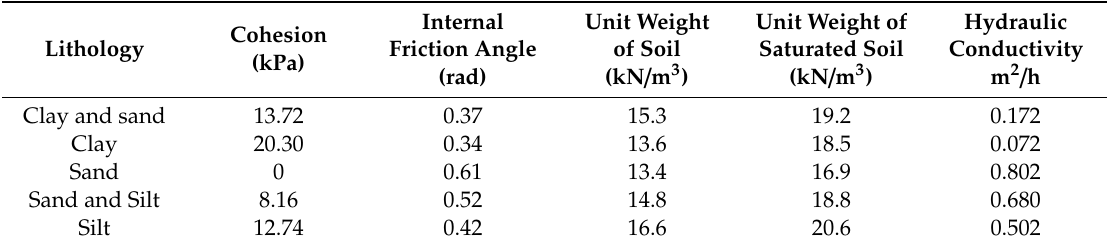
Table 3. Geotechnical parameters of the study area.